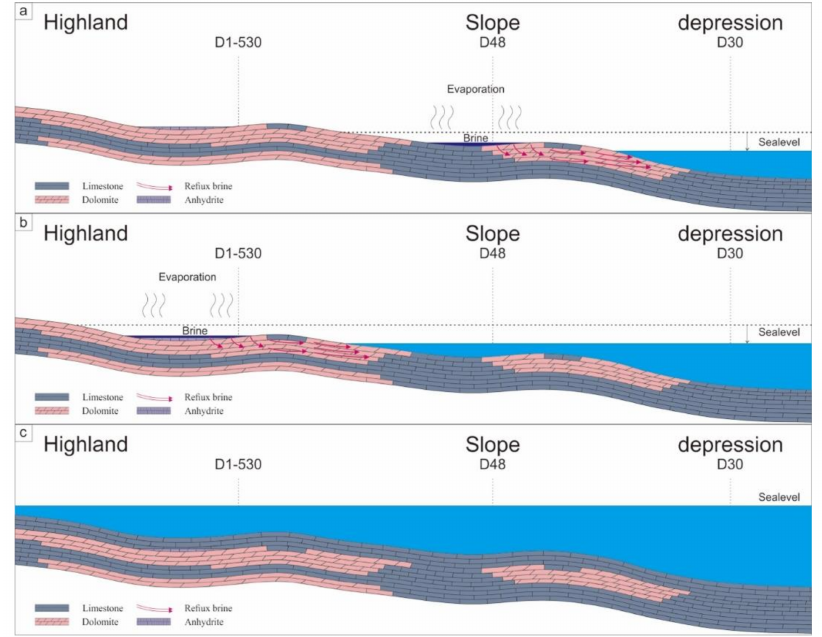
Figure 7. Dolomitization model in M 55 in Daniudi Gas Field, Ordos Basin. ( a ) Slope dolomitization during regression period; ( b ) Highland dolomitization during the transgression period; ( c ) Limestone was deposited during the highest sea level